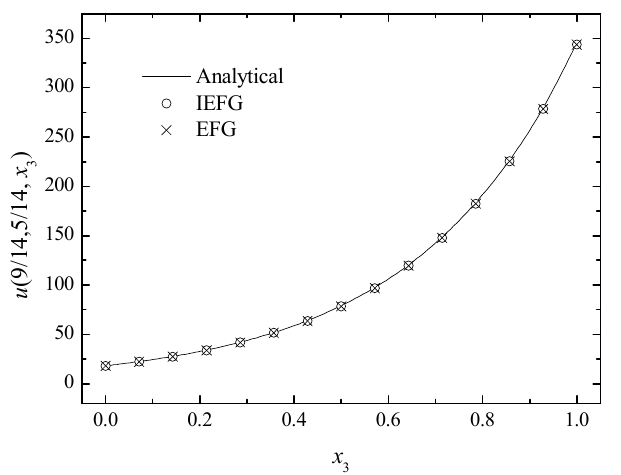
Figure 12. The comparison of the numerical and analytical solutions of the two methods along the x 3 -axis.